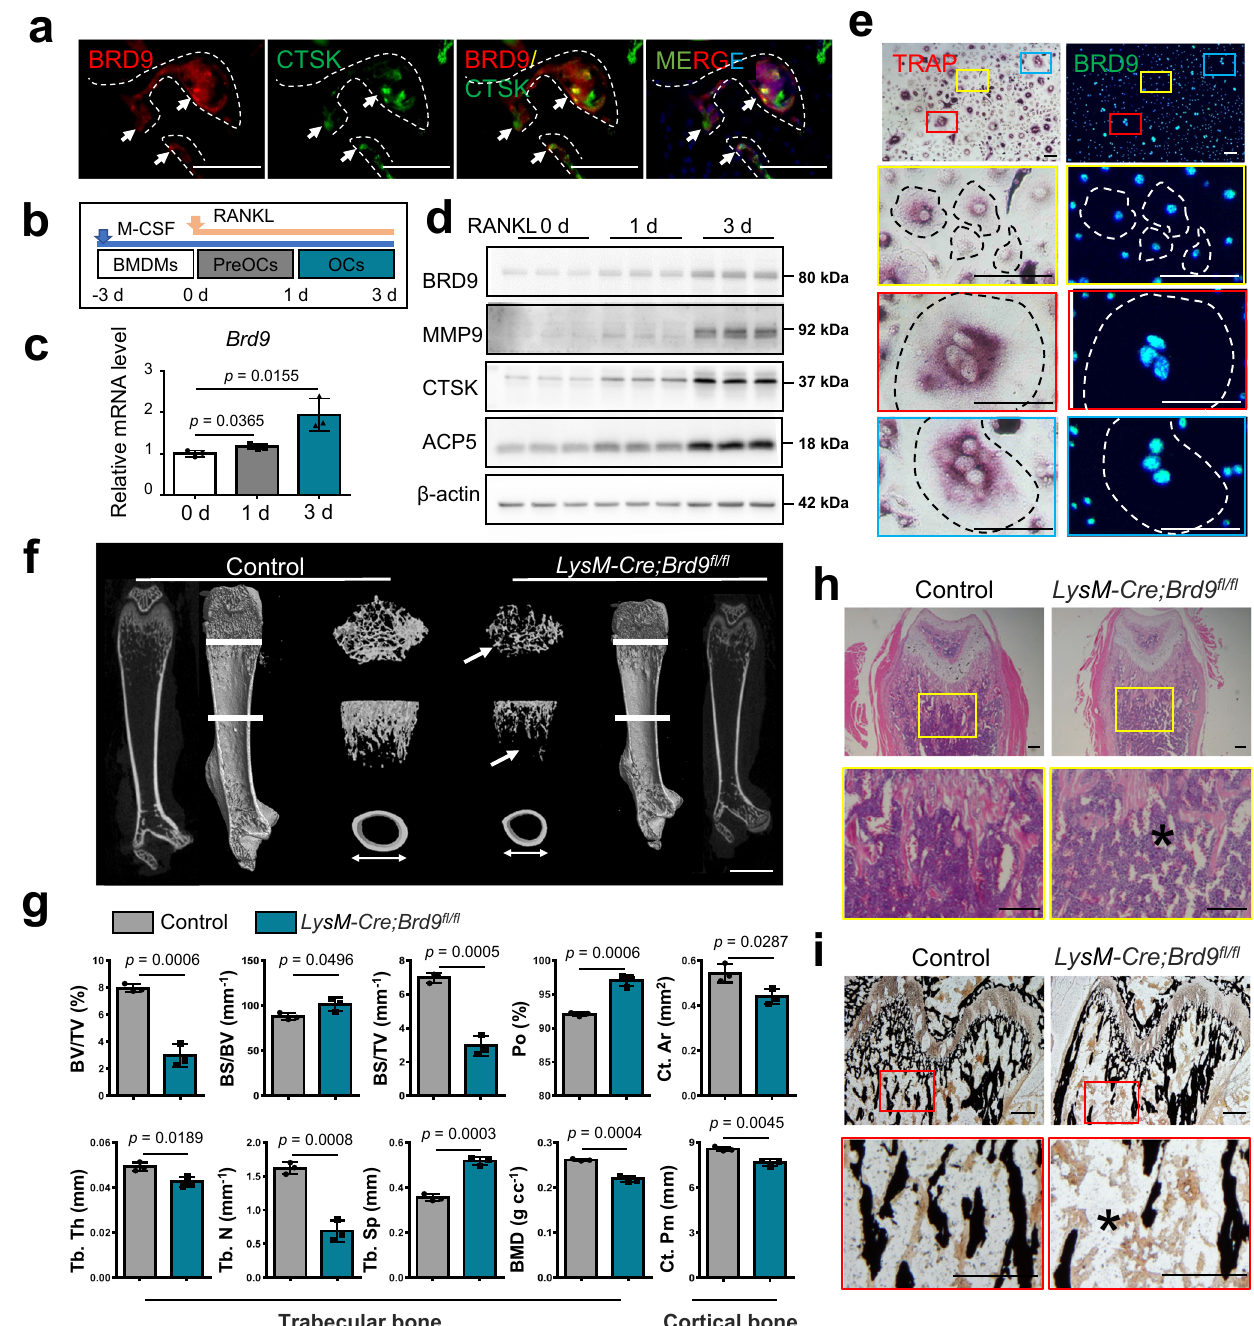
Fig. 1 | Loss of Brd9 in myeloid lineage leads to less bone mass. a Immuno fl uorescencestainingofBRD9(red)andCTSK(green)inthemousedistal femur at4weeks of age.White dashed linesoutline the surfaceof trabecular bone. Scale bar, 100 μ m. b Schema for osteoclastic differentiation stages of BMDMs invitro.Bone marrow-derived monocytes,BMDMs,osteoclastprecursors,preOCs, andmaturedosteoclast,OCs. c Brd9 mRNAexpressioninBMDMsatindicateddays after RANKL-induction, as measured by qPCR. n =3 biologically independent samples. d BRD9,MMP9,CTSKandACP5proteinexpressioninBMDMsatindicated days after RANKL-induction. e Immuno fl uorescence staining of BRD9 (green) and TRAP staining (red) in BMDMs after 3 days of RANKL-induction. Colored boxes in the fi rstpanelare shownathighermagni fi cation in below.Dashedlines outlinethe cell boundaries. Scale bar, 100 μ m. f Representative micro-CT image of the distal trabecularboneandcorticalboneoffemursfrom4-week-old LysM-Cre;Brd9 fl / fl mice and littermate control mice. Arrows indicates the decreased bone mass. Scale bar,